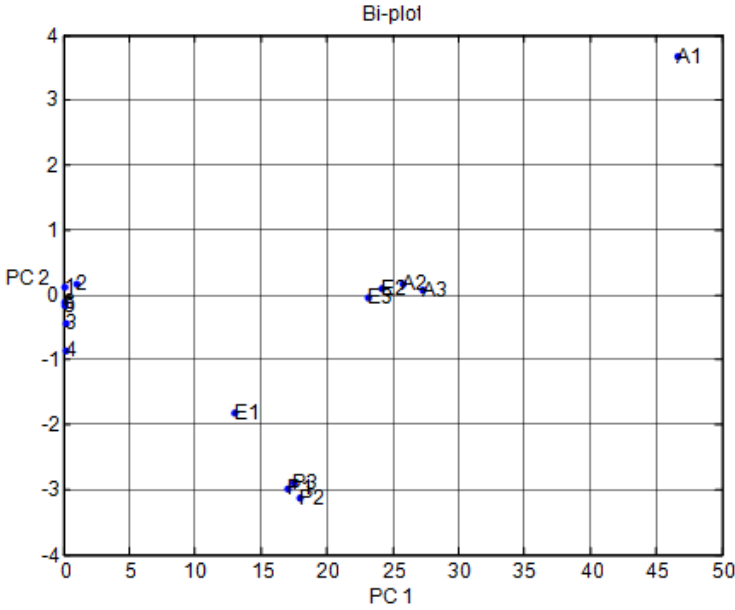
Figure 9. Multivariate technique on organic gases fractional feature Bi design.